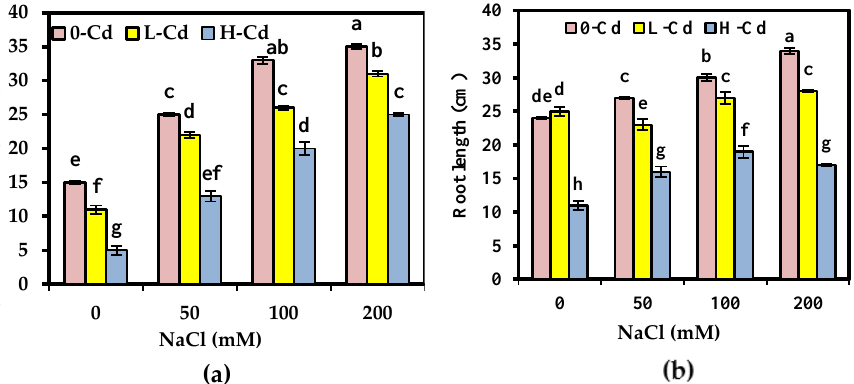
Figure 1. Aboveground biomass (g DW plant − 1 ) and root length (cm) ( a , b ) of Salicornia fruticosa exposed to nutrient solution containing 0, 25, and 50 µ g L − 1 Cd (0-Cd, L-Cd, and H-Cd, respectively) without or with 50, 100, and 200 mM NaCl. Each value is the average of four replicates ± SE. Values bearing different letters are significantly different at p < 0.05 based on Tukey’s test. DW: dry weight .